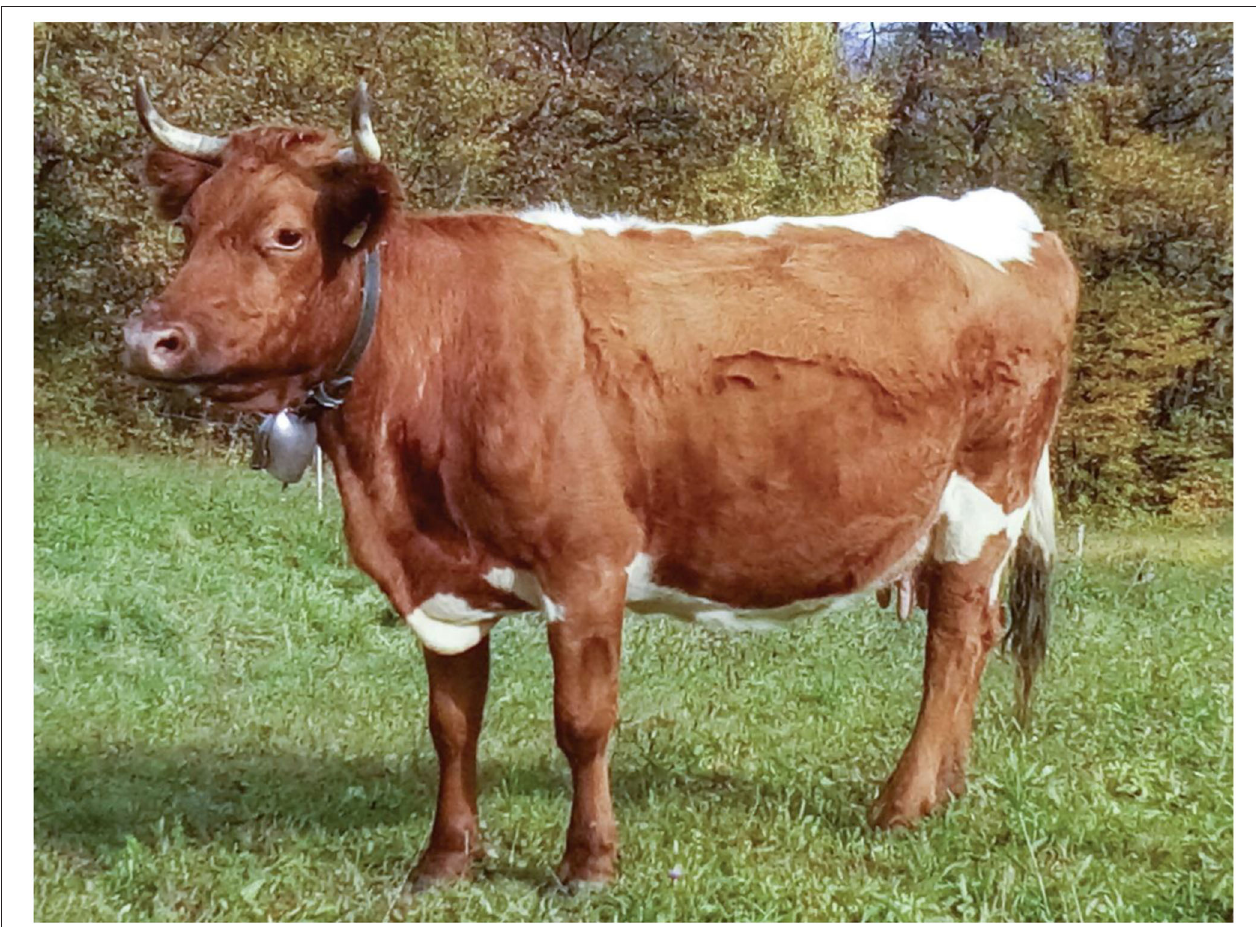
FIGURE 2 | Autochthones Slovenian Cika breed [Foto by Podobnik Franci https://www.cikastogovedo.si/wp-content/uploads/2018/02/veselka-si-43459306- podobnik-franci.jpg (accessed December 21, 2020)]. do not participate in the official programme, they cannot have the official